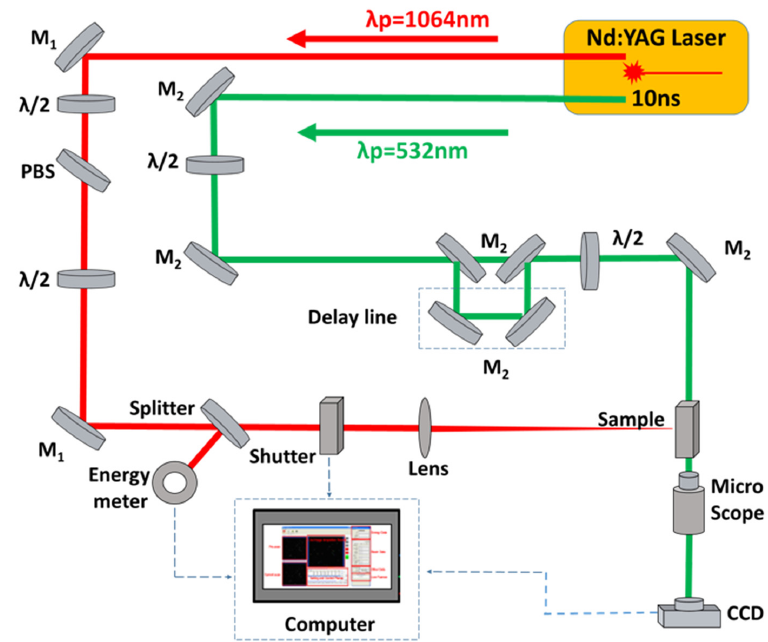
Figure 7. Optical path diagram of the laser damage threshold test.